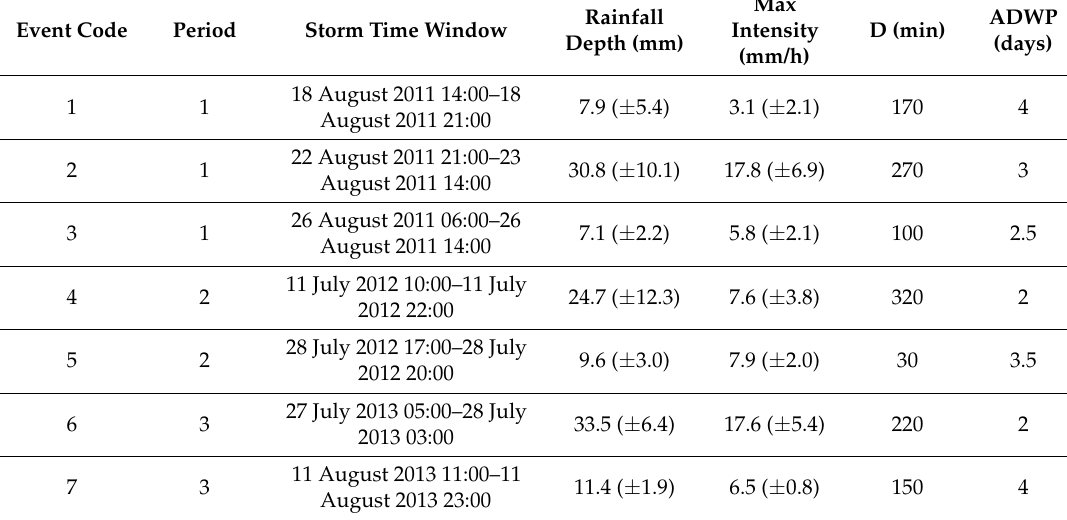
Table 1. Storm characteristics. Rainfall volume and maximum intensity computed from five rain gauges within the Eindhoven catchment. ADWP stands for antecedent dry weather period length. D refers to the duration of the rainfall in minutes. All variables were calculated from the 10-min accumulated time